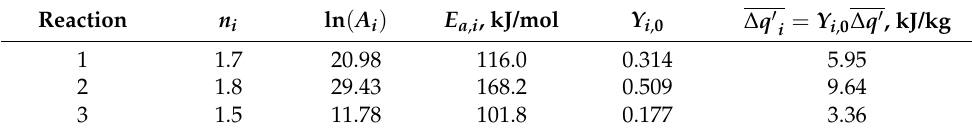
Table 1. Kinetic parameters of three reactions used to approximate the MCC data.